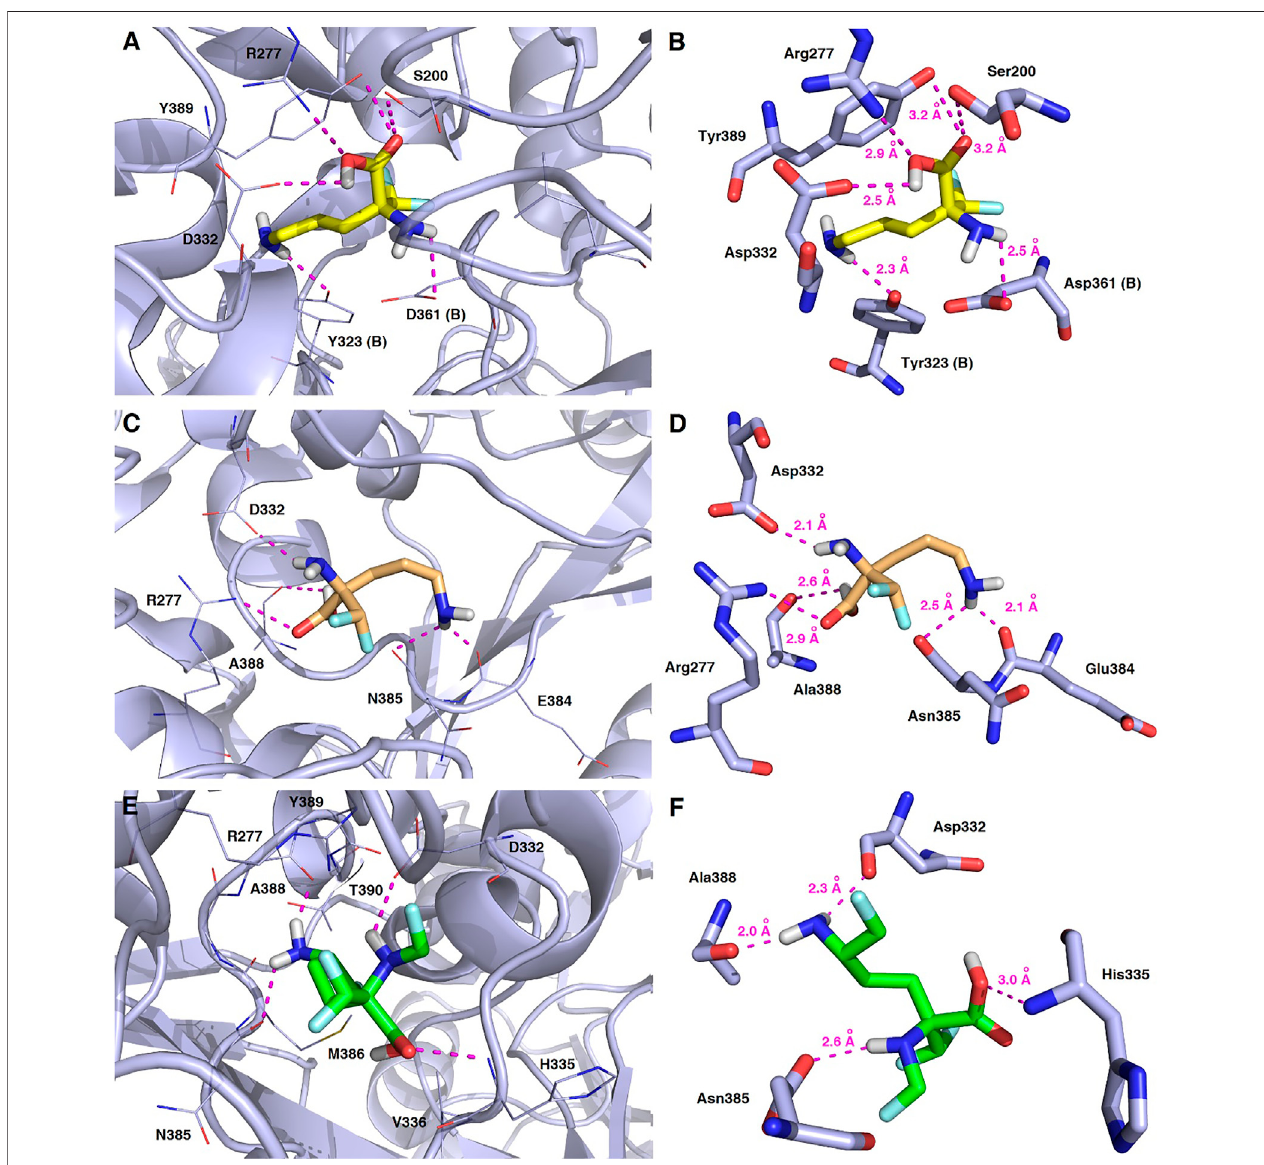
FIGURE 13 | Representative binding modes of L -DFMO (A,B) , D -DFMO (C,D) , and the DFMO-analogue ( E,F ) to human ornithine decarboxylase without PLP- cofactor (h-ODC, PDB ID: 2OO0) (Dufe et al., 2007) with close contacts to residues in the active site. All six panels (A – F) show inhibition of h-ODC by blocking the substrate-bindingsitethroughdirectinteractionoftheligandswithcriticalaminoacidsofthereceptorinthecatalyticcavity.Ligandsareshownasstickscoloredinyellow ( L- DFMO), gold ( D -DFMO) or green (DFMO-analogue), respectively. The overall enzyme structure is shown as a light blue cartoon diagram (see A,C,E ). The most signi fi cant amino acid residues contributing to the stabilization of the ligand molecules in the complex with h-ODC by polar interactions and by CH – CH van der Waals (vdW) interactions are shown in light blue sticks (see B,D,F ) representations. Nitrogen atoms are presented in blue, oxygen atoms in red, fl uorine atoms in light blue, whereas hydrogen atoms (attached to nitrogen and/or oxygen atom of the carboxylic group) in gray. Mutual distances between the amino acid residues, and the respective ligands ’ atoms are given in Ångstro ̈ m (see B,D,F ). The formation of intermolecular hydrogen bonds is represented by magenta dashed